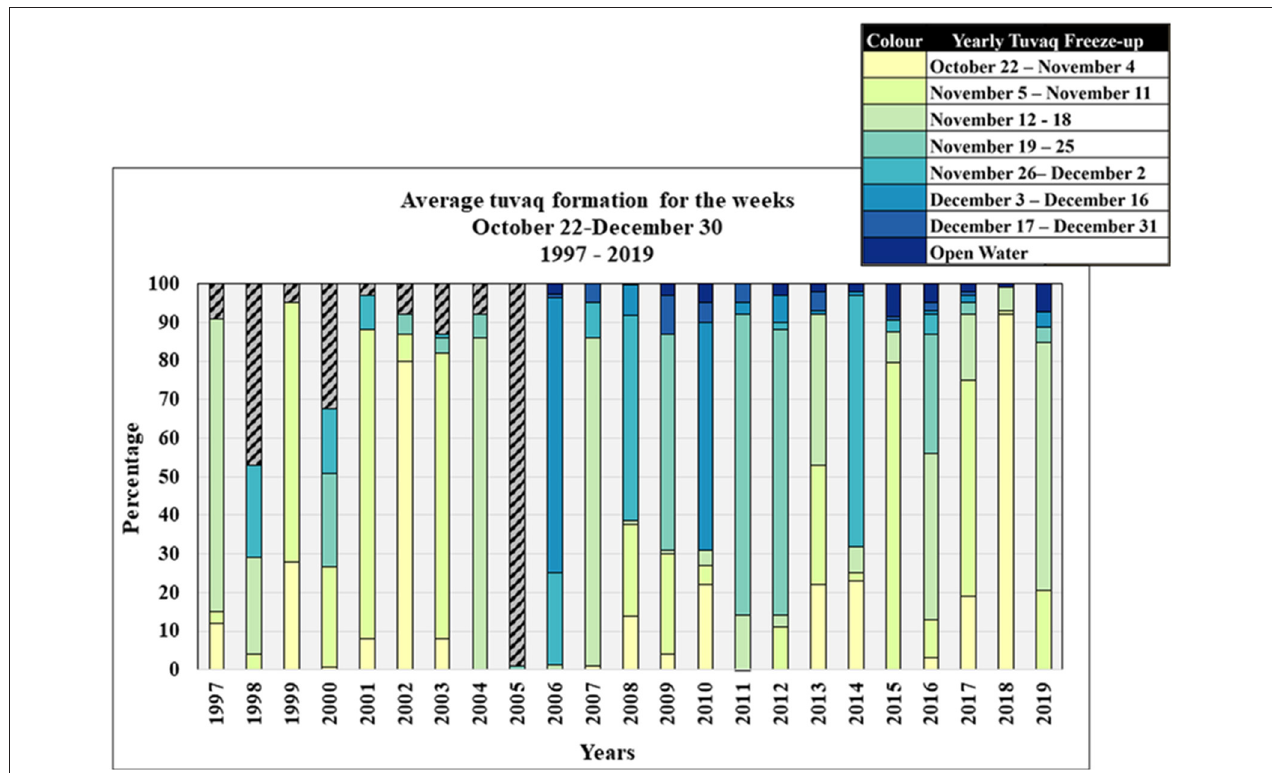
FIGURE 6 | Summary graph of average tuvaq formation for freeze-up, 1997–2019. Each bar is a year showing the weekly percentage of tuvaq freeze-up by color: yellow for late October; green for November; blue for December; and dark blue for remaining areas of open water at the end of December. Years with more blue represent the late formation of tuvaq. Years with more yellow represent the early formation of